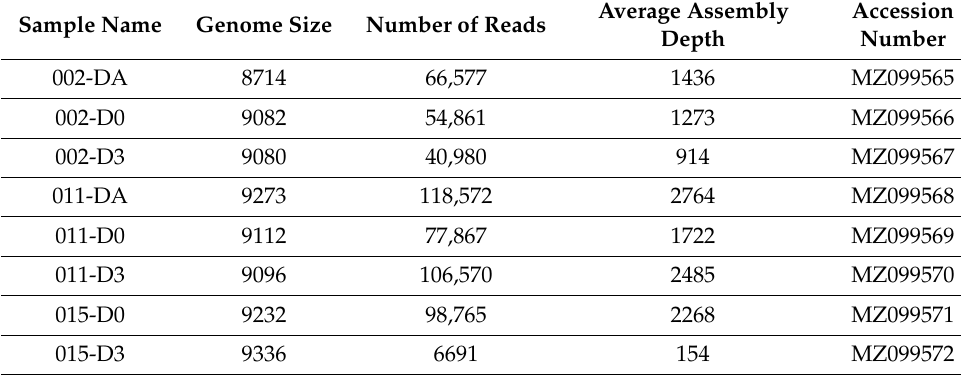
Table 3. Human pegivirus-1 (HPgV-1) genome assembly